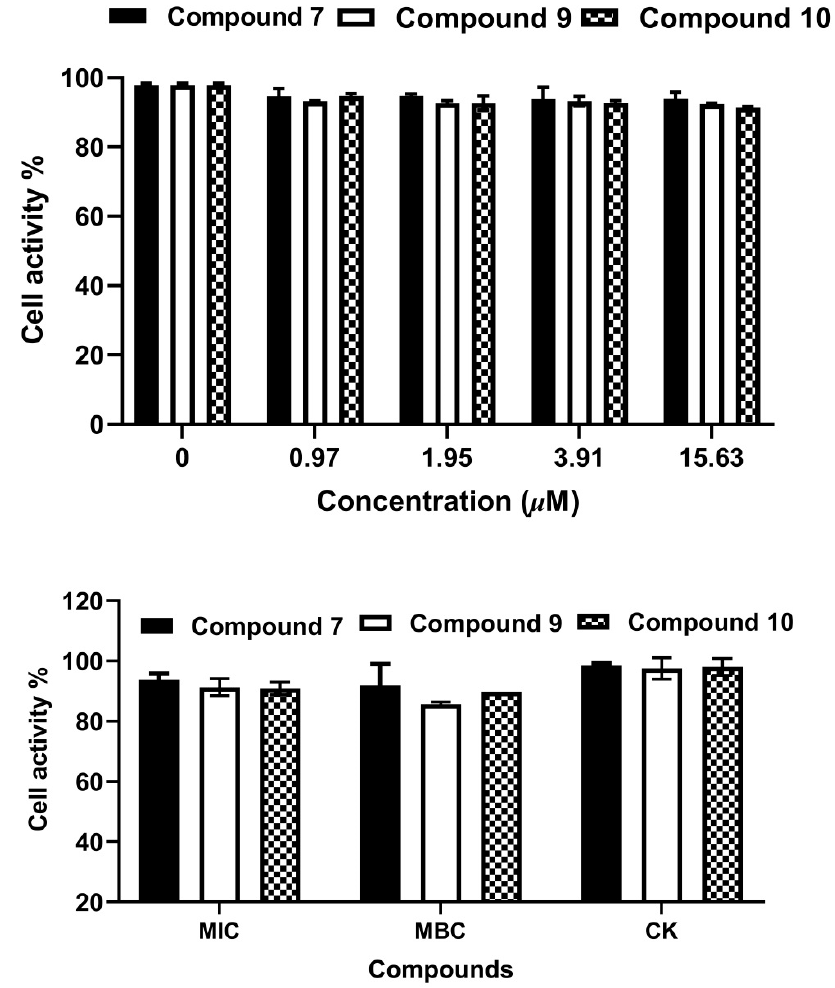
Figure 7. Cytotoxicity of compounds 7 , 9 and 10 on PC-12.